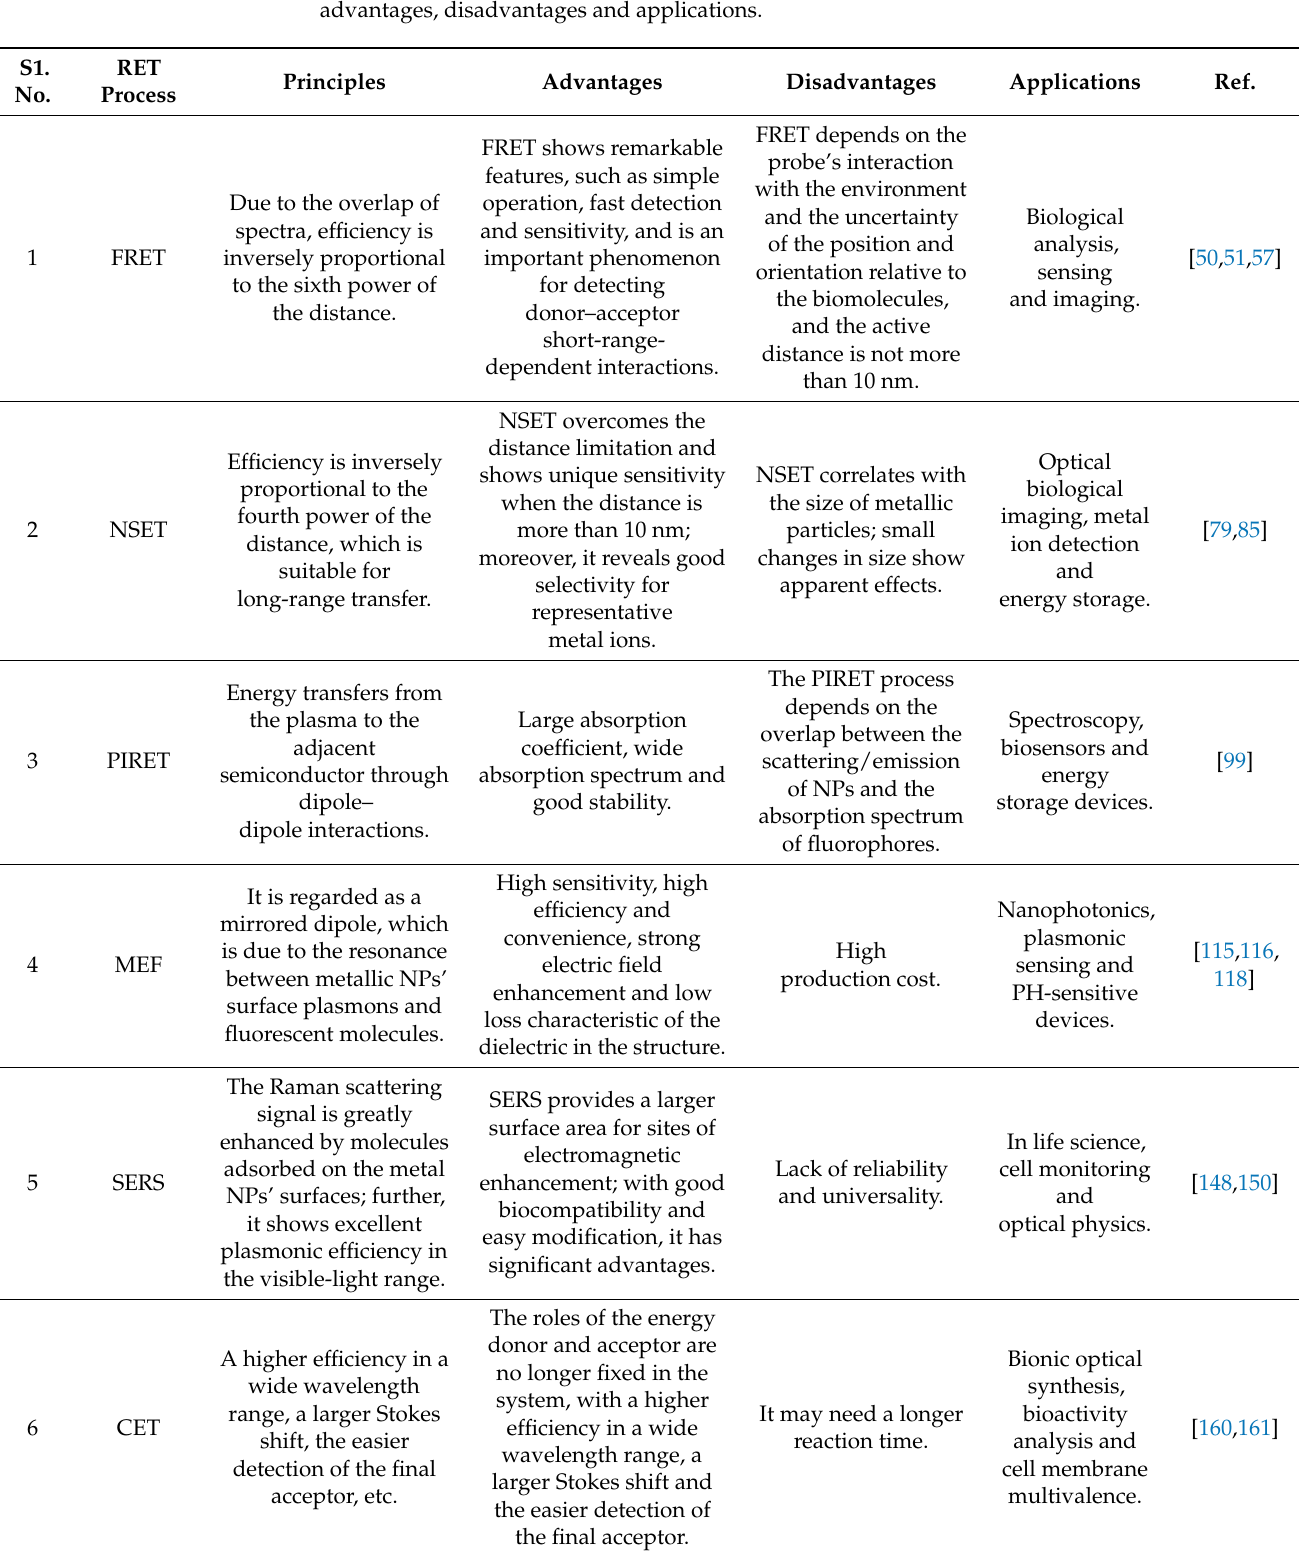
Table 1. Different resonance energy transfer processes involving plasmonic noble metal NPs with advantages, disadvantages and